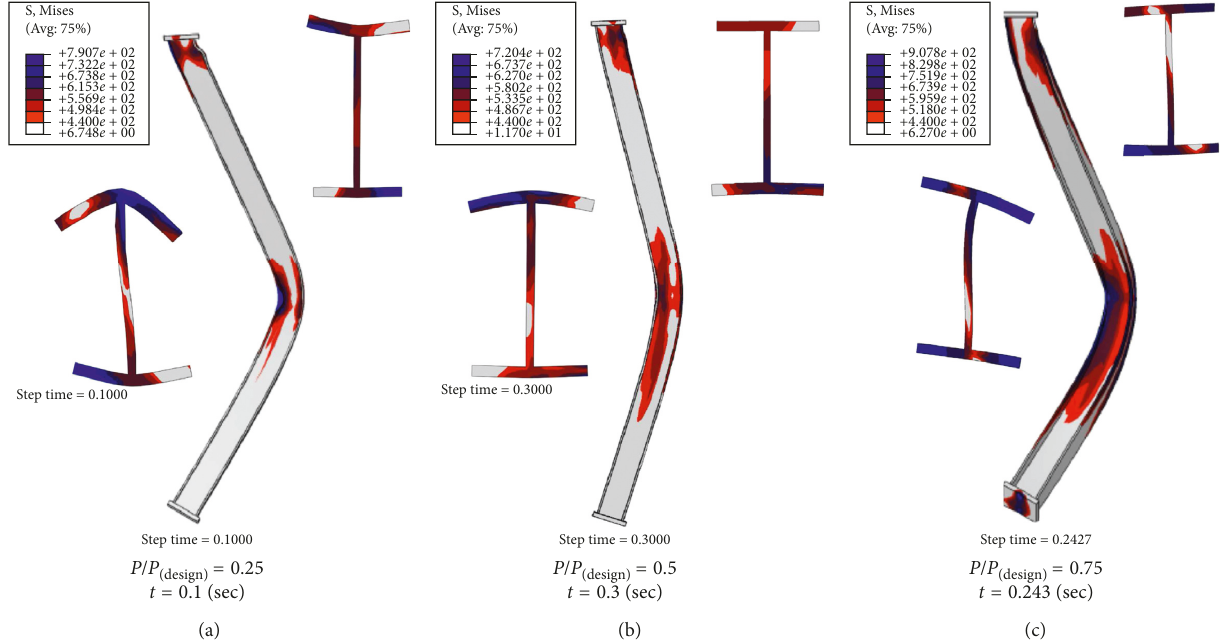
Figure 21: Deformation shape and plastic hinge locations of propped cantilever column W150